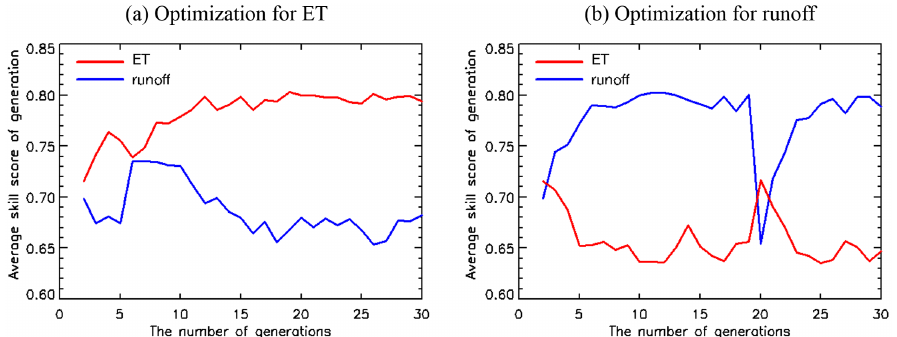
Figure 3. Evolution of generations during the processes of the MP–MGA optimization for (a) ET and (b) runoff. The red and blue lines indicate the averages of ET and runoff in each experiment, respectively.